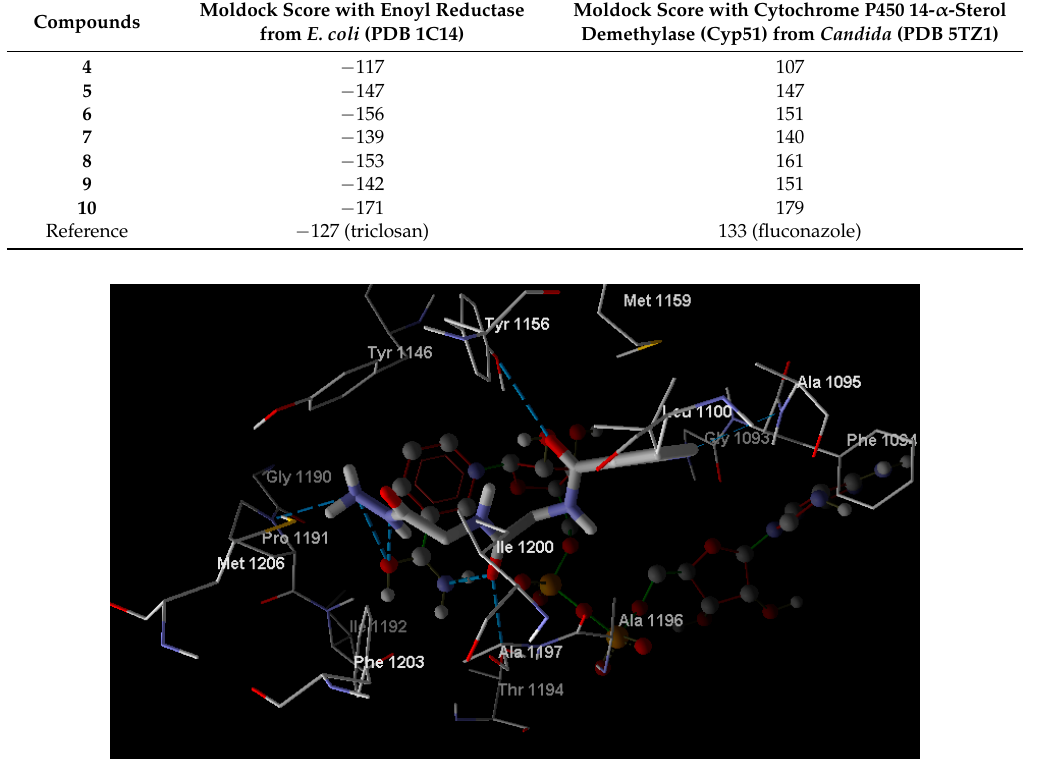
Table 2. MolDock scores of the tested compounds.